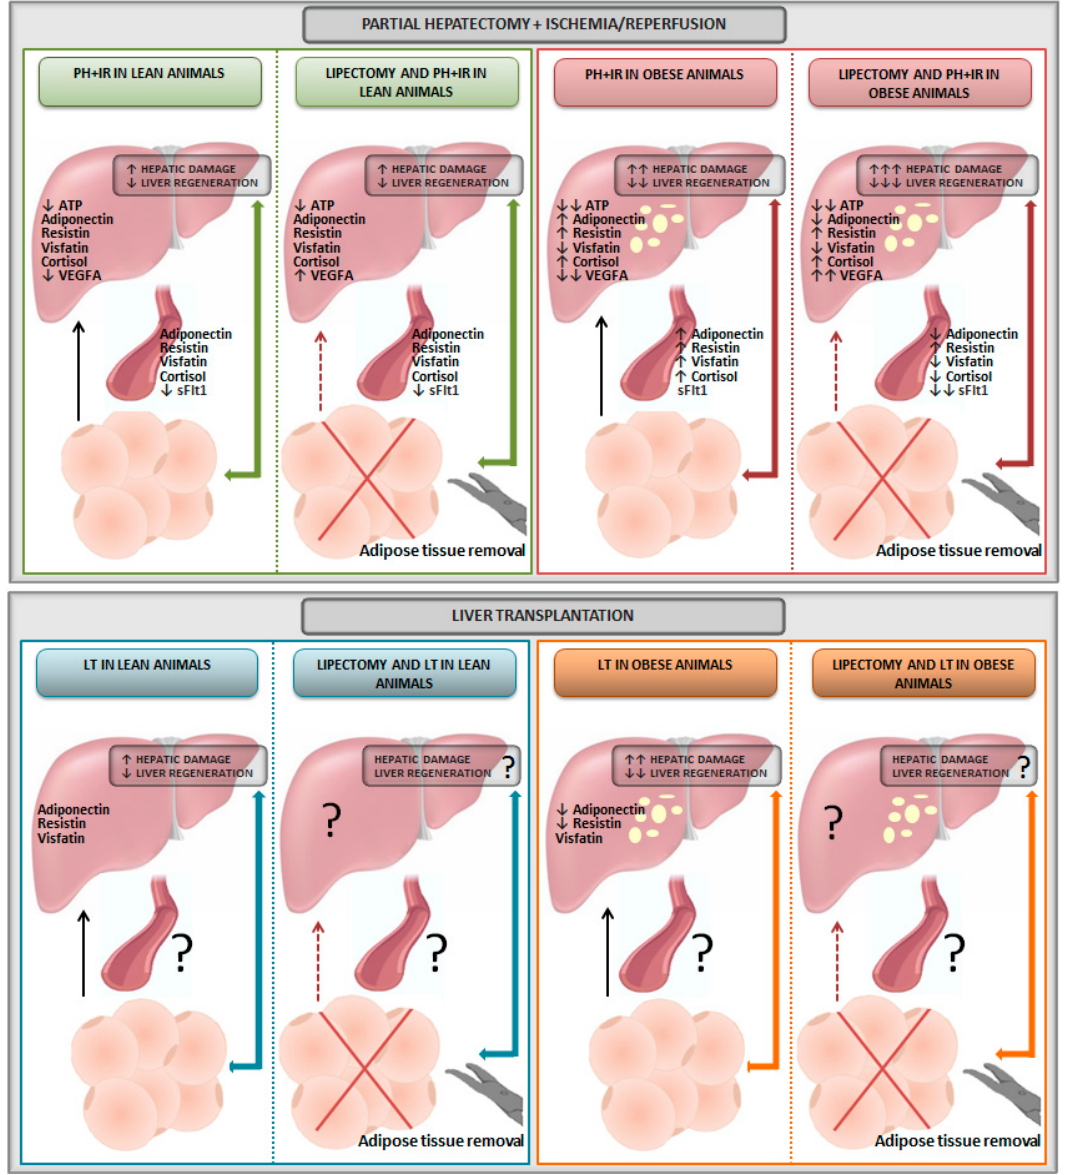
Figure 4. Schematic illustration of lipectomy effects in liver surgery. Abbreviations: ATP, adenosine triphosphate; I/R, ischemia–reperfusion; LT, liver transplantation; PH, partial hepatectomy; sFlt1, soluble form of the VEGF receptor 1; VEGFA, vascular endothelial growth factor type A.